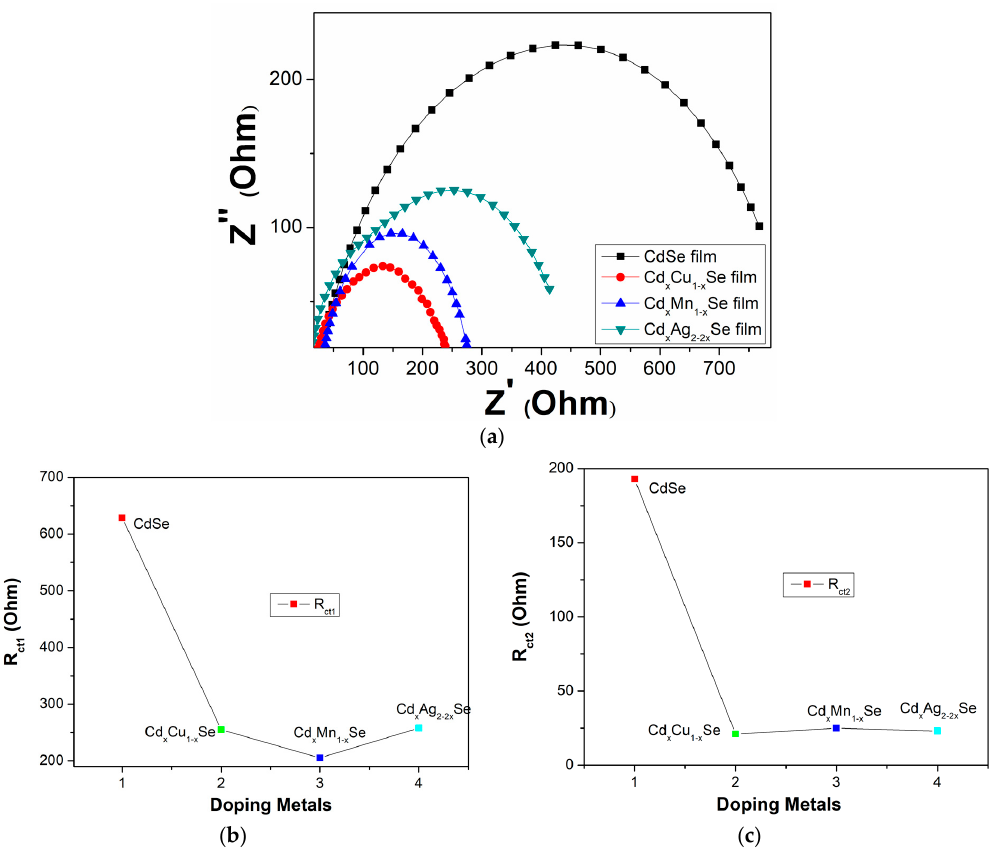
Figure 9. ( a ) Variation of the Electrochemical Impedance Spectra and ( b ) dependence of the recombination resistances: ( b ) polyelectrolyte and polyelectrolyte/counter electrode contact (R ct1 ) and ( c ) TiO 2 /QDs contact and diffusion resistance in TiO 2 films (R ct2 ).